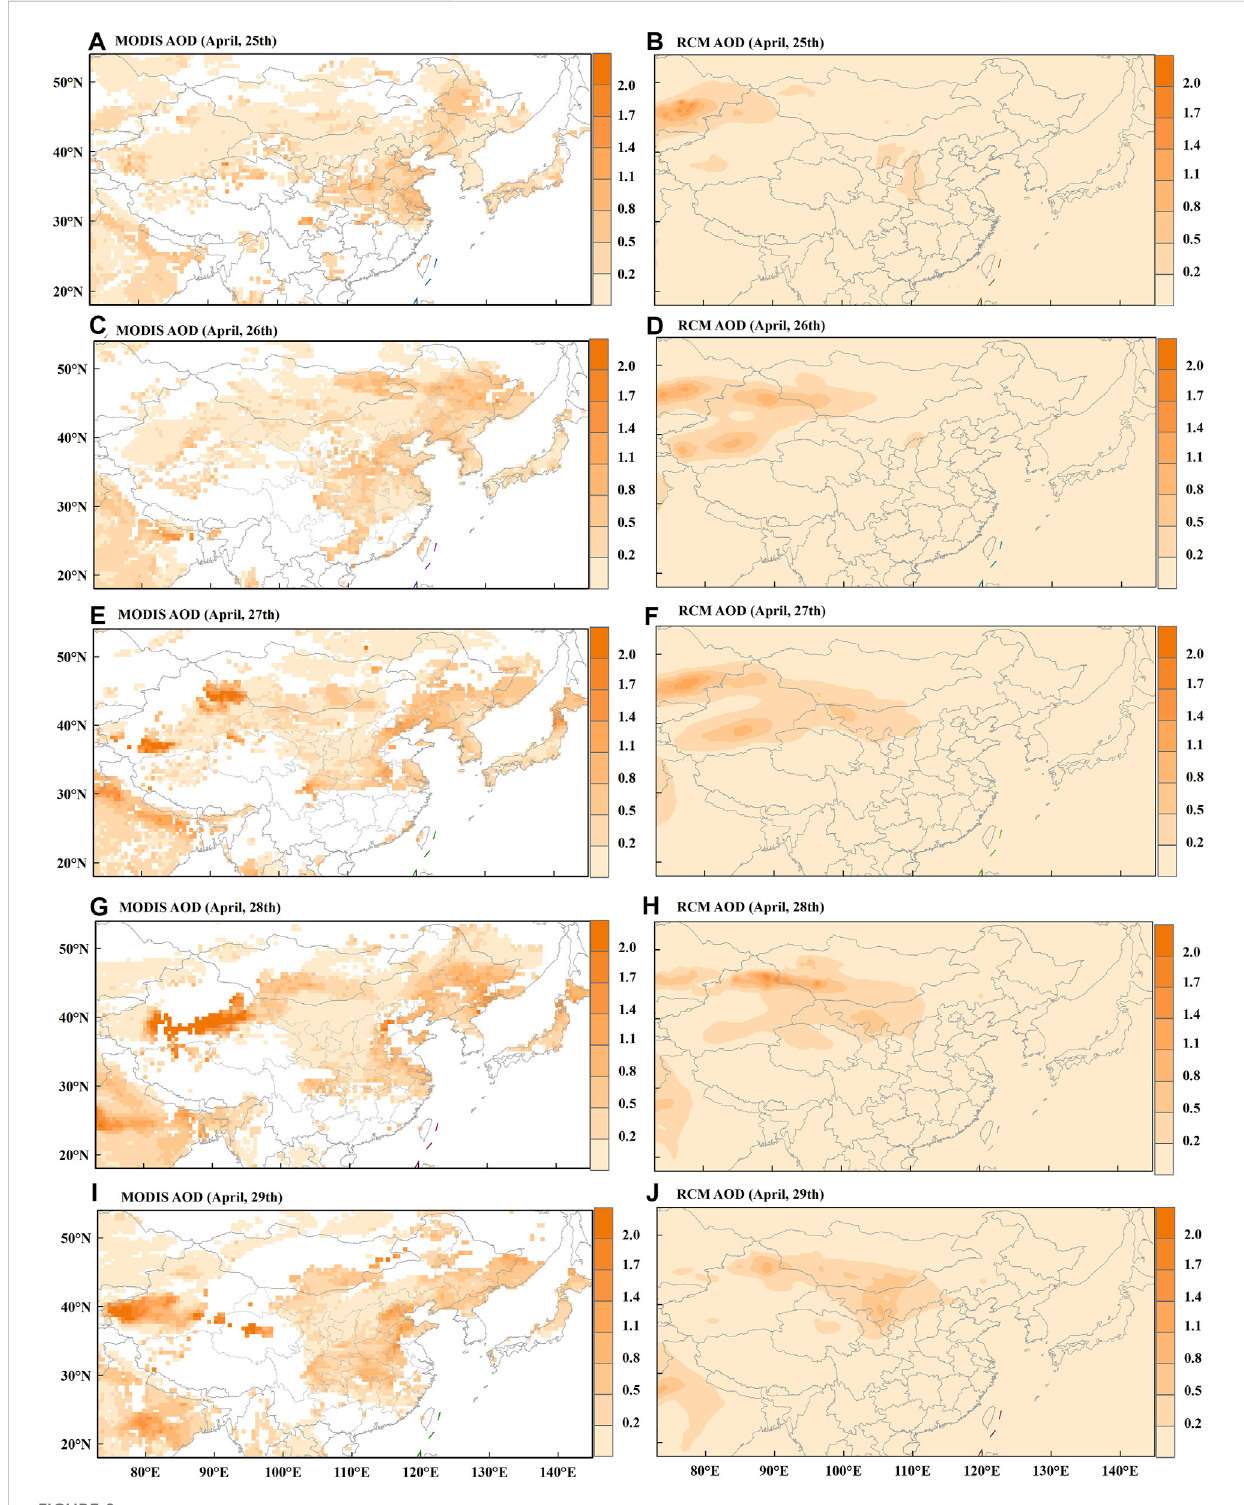
FIGURE 9 Spatial distributions of MODIS AOD (A, C, E, G, and I) and RCM AOD (B, D, F, H, and J) in eastern Asia during April 25 – 29,